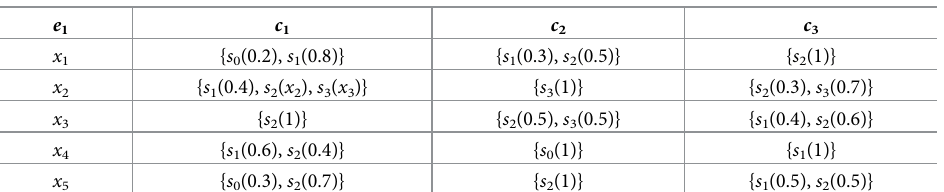
Table 1. The decision matrix of e 1 .